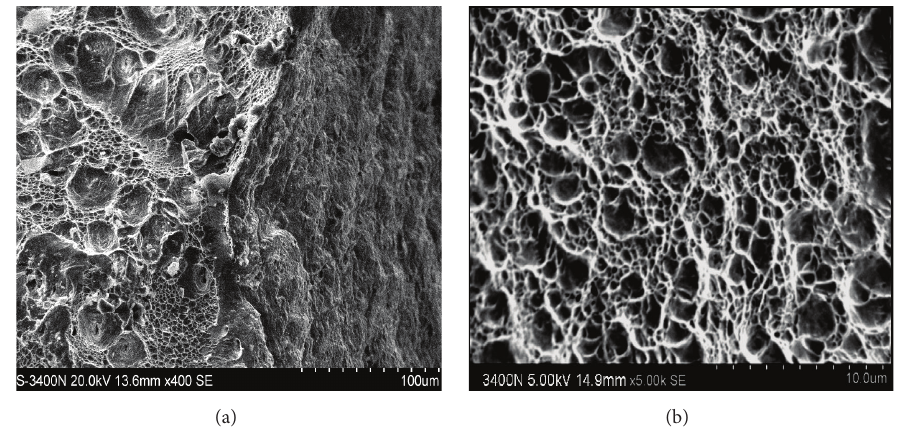
Figure 4: SEM fractographs: (a) on the left is the matrix and on the right is the NSSL; (b) nanostructured layer.